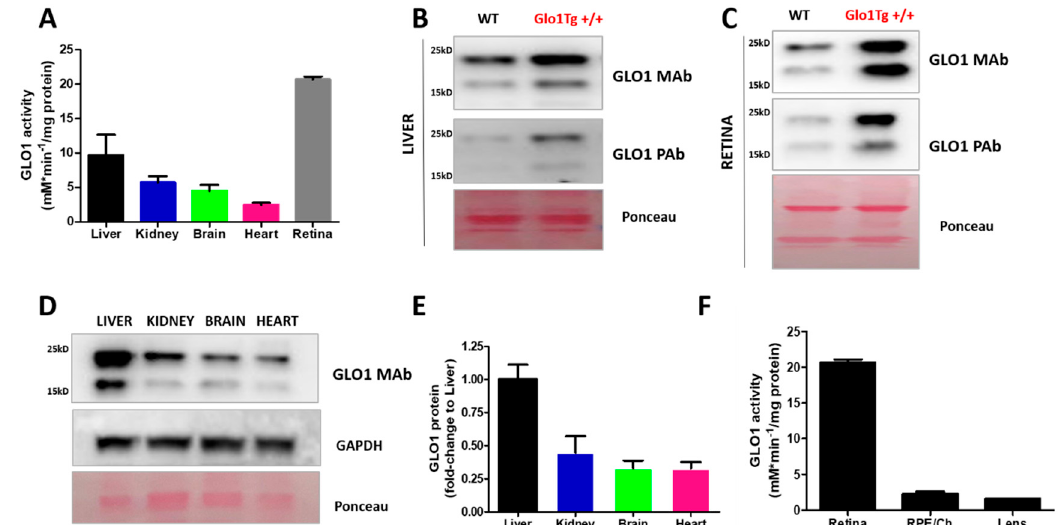
Figure 3. A comparative analysis of GLO1 protein and activity in ocular and non-ocular tissues. ( A ) GLO1 activity was assayed in non-ocular tissues and retinal tissues from WT mice as previously described [29] and activity was expressed as percentage (%) compared to liver. ( B ) Liver and ( C ) retina representative Western blot analysis of WT and Glo1 overexpression transgenic mice (Glo1 Tg+/+) using a monoclonal antibody (non-commercial) and polyclonal antibody for Glo1 (commercial, GeneTex) [36,103,104]. ( D ) Representative Western blot analysis of non-ocular tissues extracts (50ug) of WT mice using a monoclonal antibody for Glo1 (non-commercial) and ( E ) protein quantification of GLO1 normalized to control loading (Ponceau staining). ( F ) GLO1 activity was performed in ocular tissues (Retina, RPE/Choroid, and Lens) from WT mice as previously described [29] and activity was expressed as milliunits per milligram of protein. Values are mean ± SEM. Sample size is n = 4 from the GLO1 protein and activity assays.